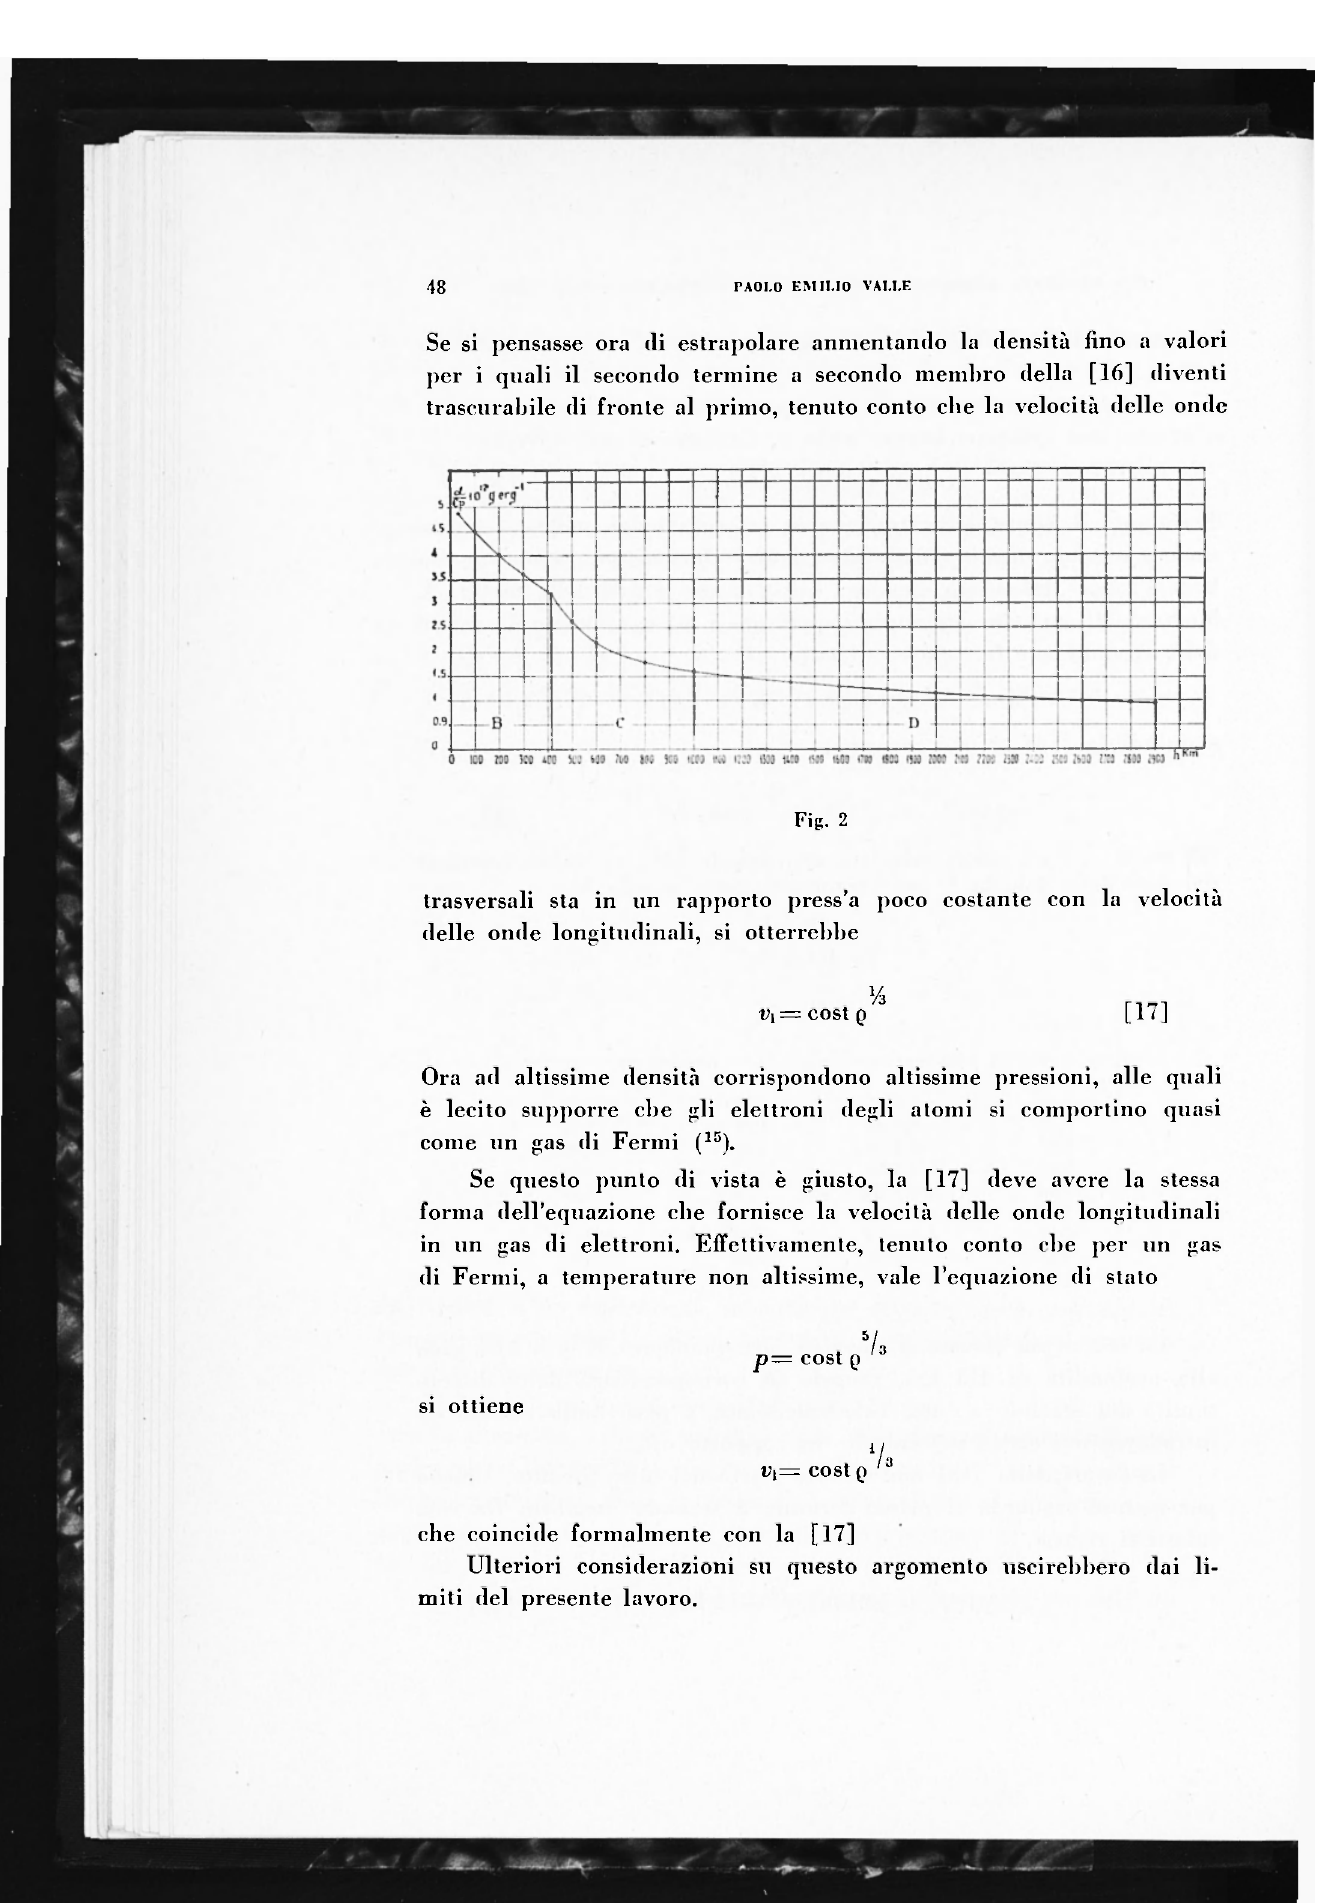
1/3 M - 71 ri=costQ L17J Ora ad altissime densità corrispondono altissime pressioni, alle quali è lecito supporre cbe gli elettroni degli atomi si comportino quasi come un gas di Fermi ( 15